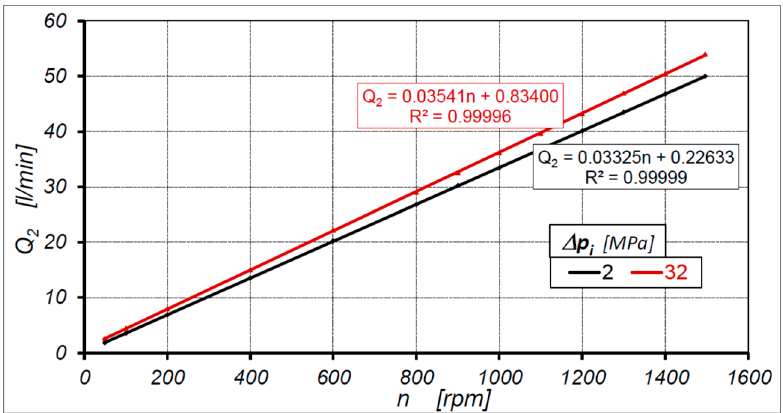
Figure 11. Characteristics of motor output flow rate Q 2 as a function of rotational speed n at ∆ p i = const . The influence of liquid compressibility is omitted [12].